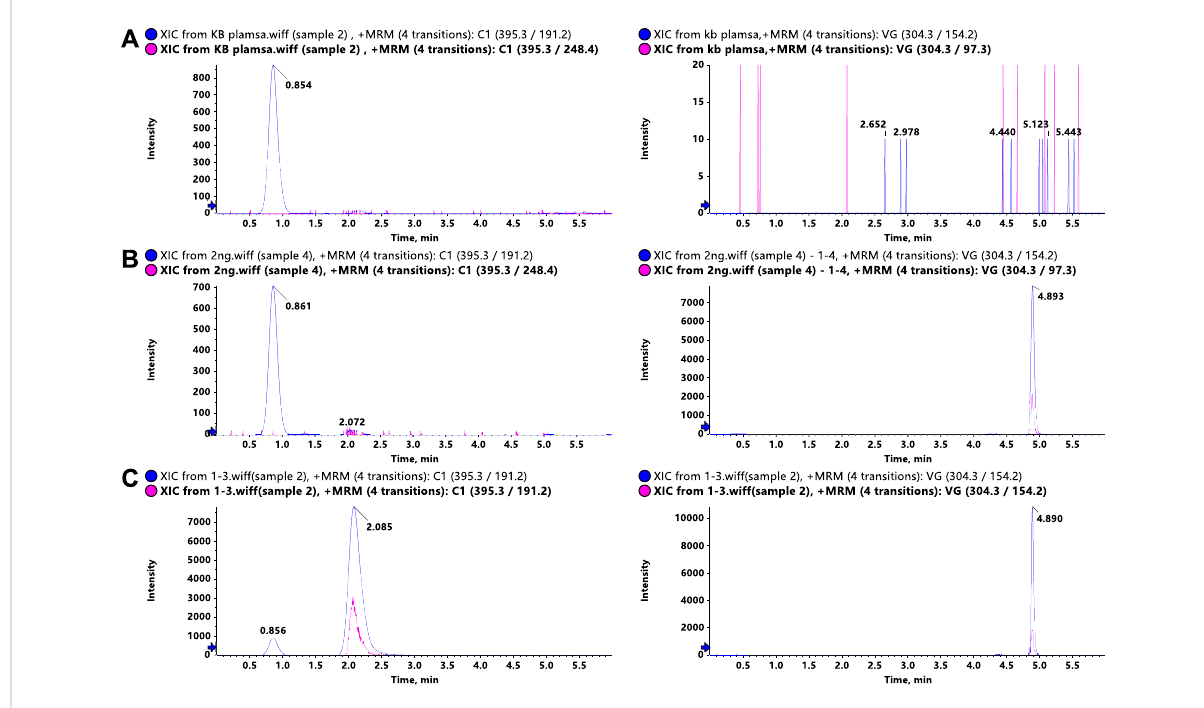
FIGURE 2 Representative LC – MS/MS chromatograms of glytrexate (left) and the IS (right) in rat plasma. (A) Blank rat plasma sample, (B) blank rat plasma sample spiked with 2 ng/ml glytrexate, and (C) rat plasma sample obtained 2 h after an oral administration of 50 mg/kg